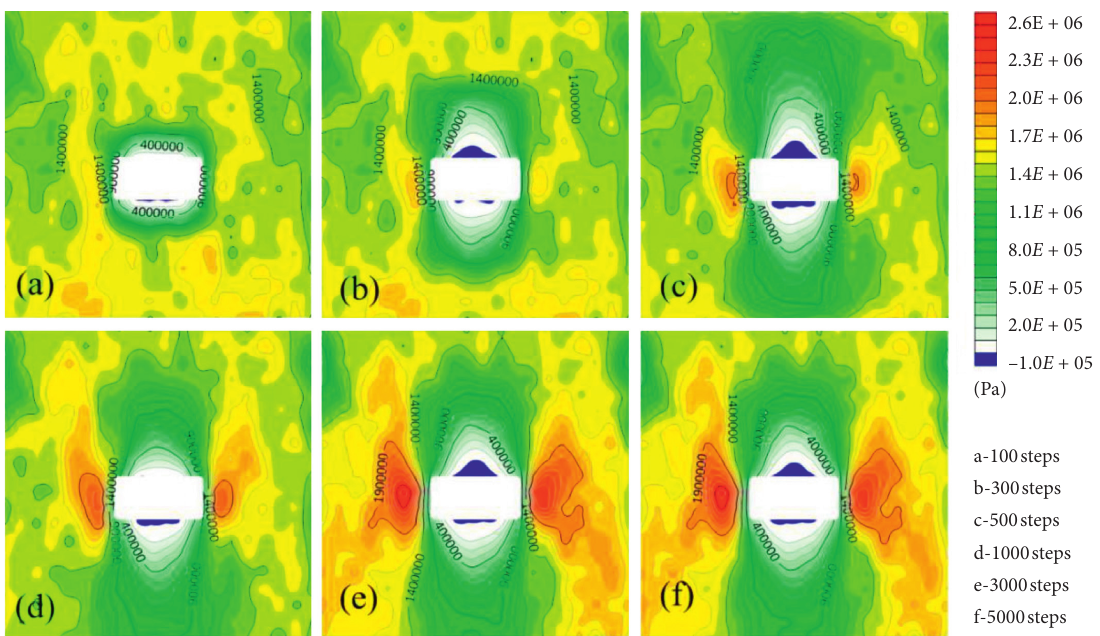
Figure 7: Vertical stress nephogram: (a) 100 steps, (b) 300 steps, (c) 500 steps, (d) 1000 steps, (e) 3000 steps, and (f) 5000